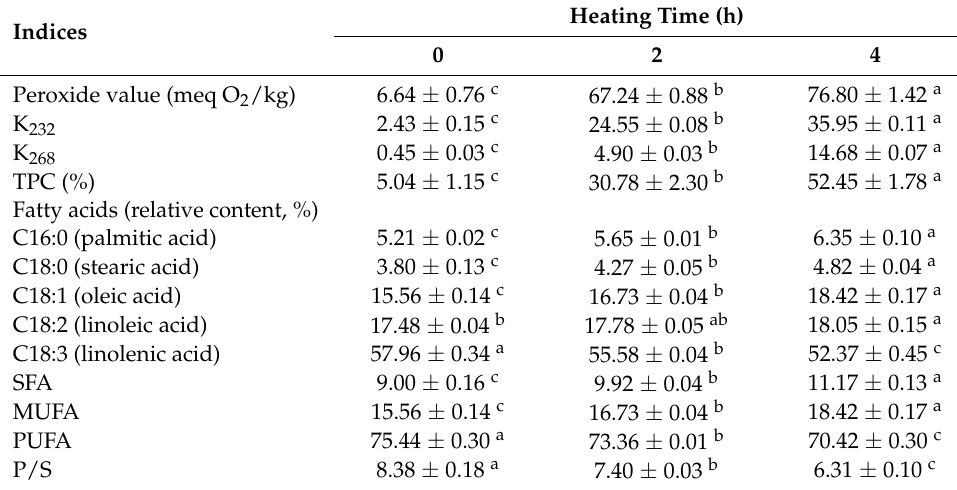
Table 1. Changes in oxidation indices and fatty acid composition (%) of flaxseed oils during heating at 180 ◦